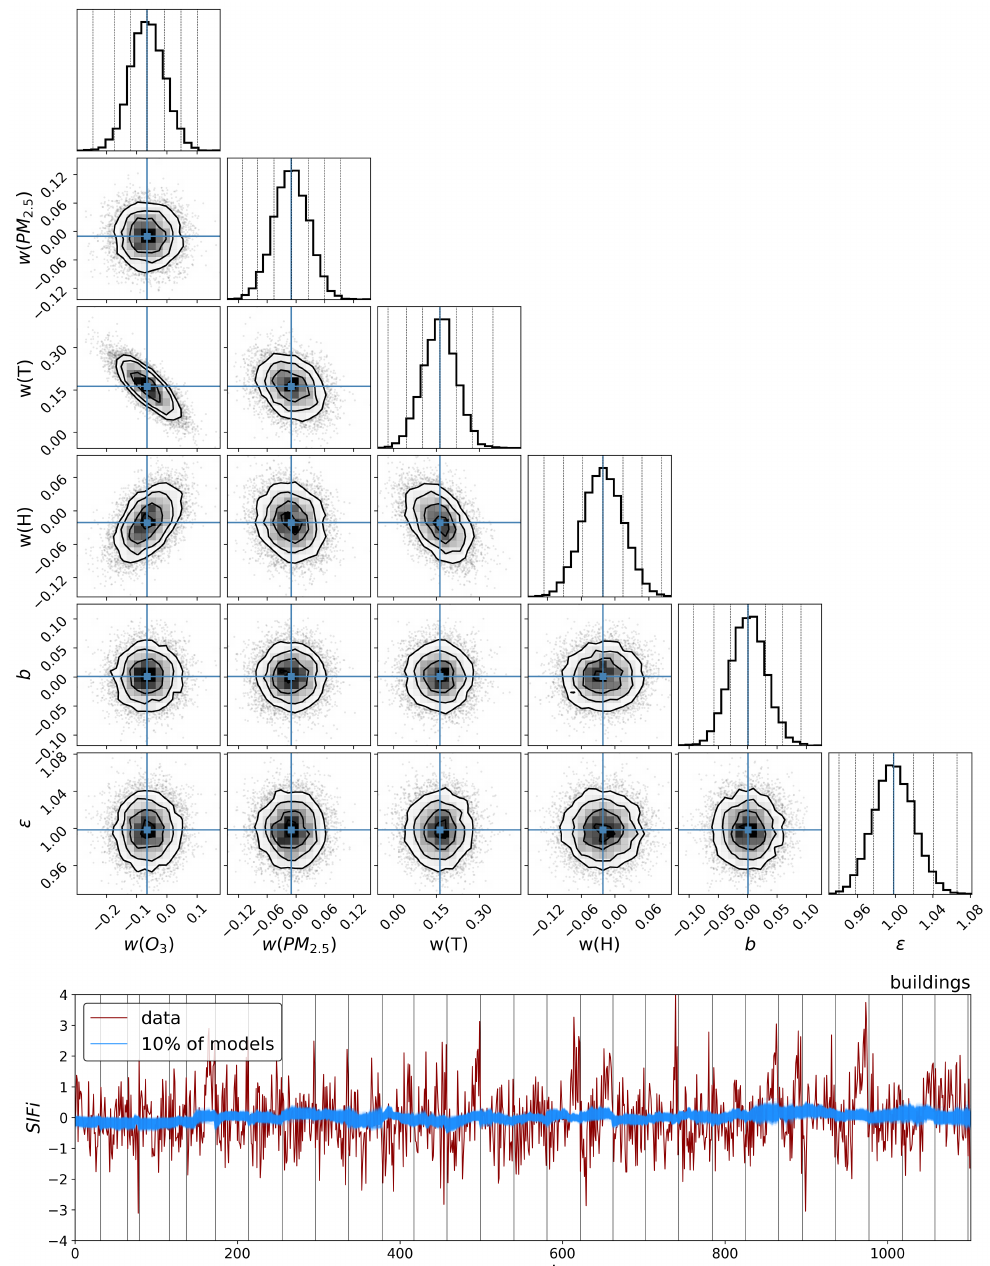
Figure 11. ( Top ): MCMC corner plot of the posterior distribution of air quality parameters for buildings. ( Bottom ): The measured SIF indicator ( SIFi ) values as a function of scan number with 10% of randomly selected models from those identified as probable by MCMC, with the vertical lines indicating the change in